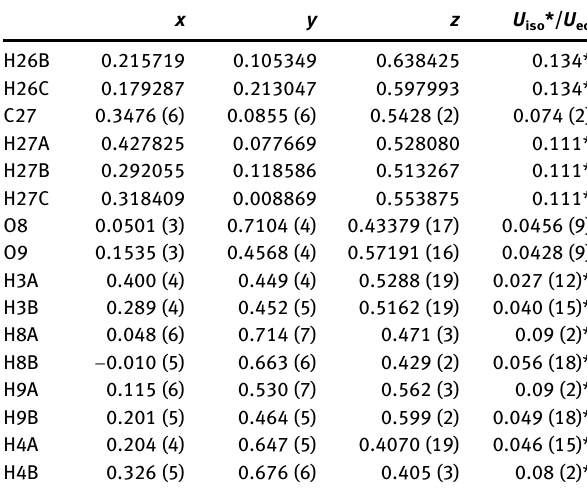
Table  : Fractional atomic coordinates and isotropic or equivalent isotropic displacement parameters (Å 